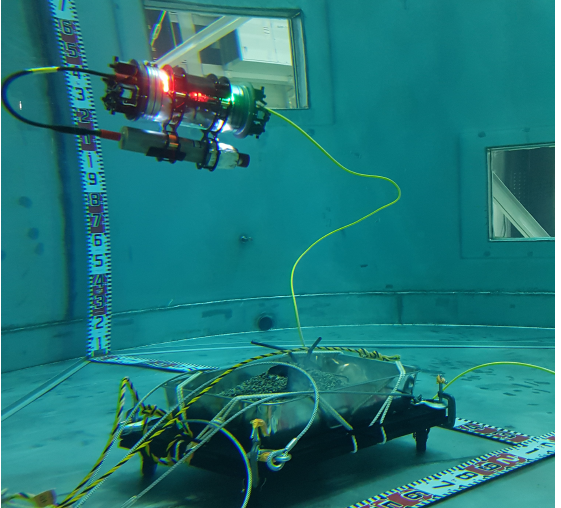
Figure 14. Deployment of the AVEXIS TM in the Naraha test tank, characterising the simulated fuel debris.